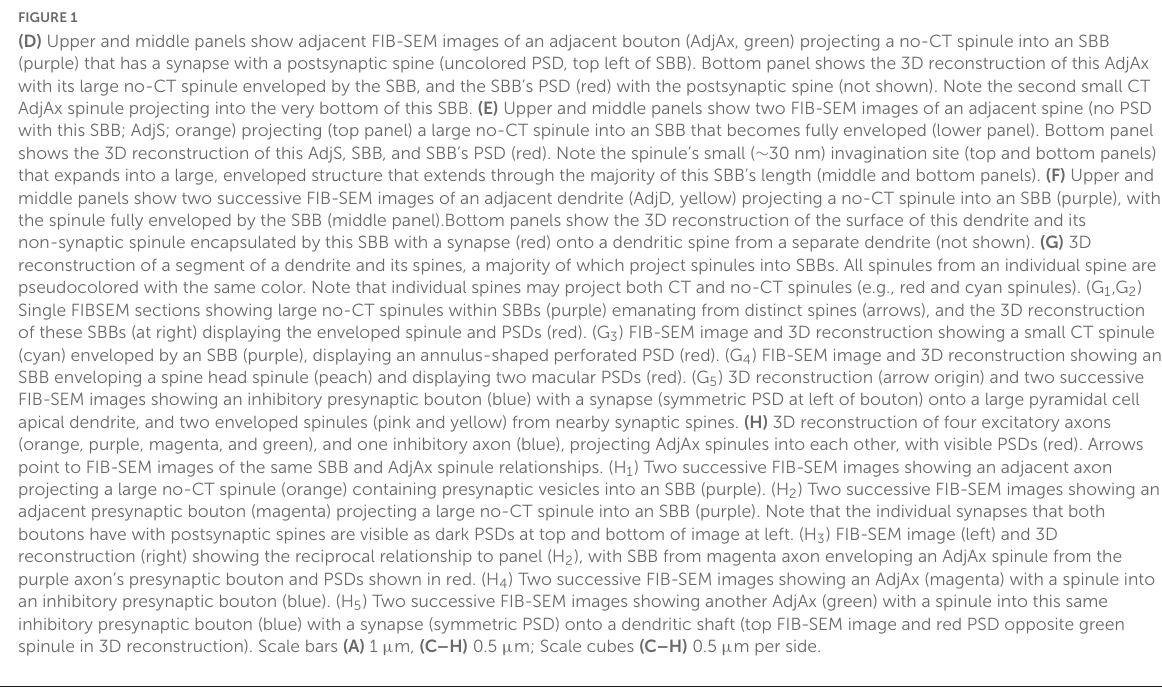
source of spinules except postsynaptic dendritic shafts. There were no detectable differences in the percentages of